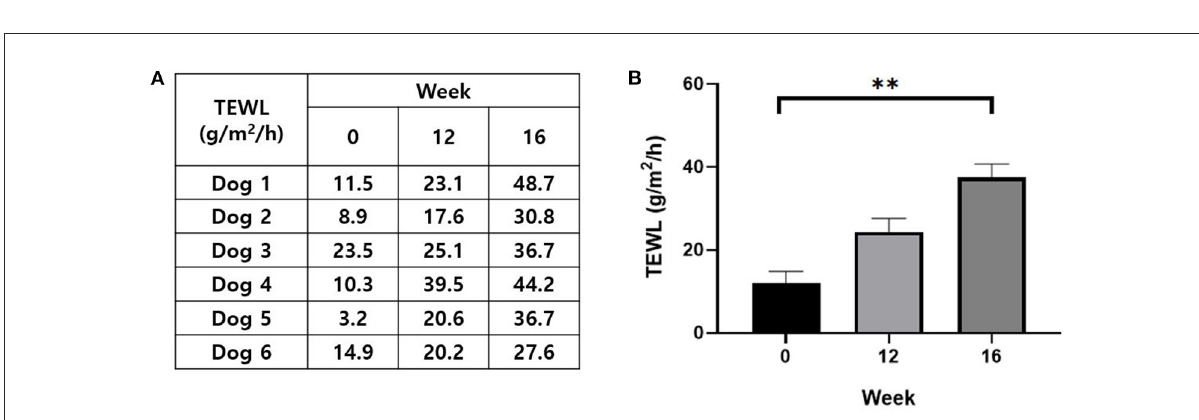
FIGURE6 Evaluation of skin barrier function. (A) The TEWL value of each subject at pre-sensitization, post-sensitization, and post-provocation. (B) Change in the TEWL with the course of time. Zero week, pre-sensitization; 12 week, post-sensitization; 16 week, post-provocation. TEWL, transepidermal water loss. All values are expressed as the mean ± standard error. ** P <